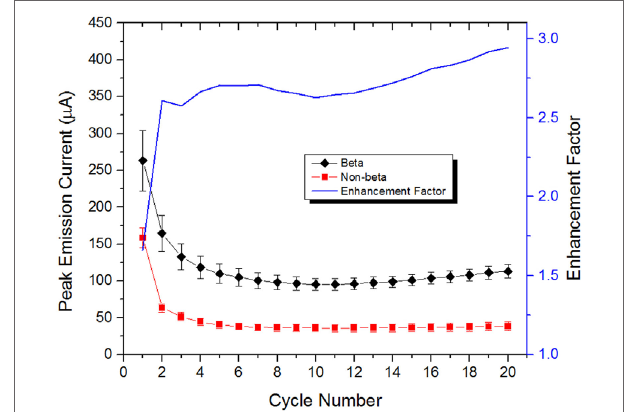
FigUre 5 | Average temporal peak emission current values for sample set A, showing the beta ( 63 Ni) current to be consistently higher than the non-beta ( 59 Ni) current. The enhancement factor (defined in the main text) is also shown on the right-hand axis. The error bars represent the standard error on the mean of all runs in sample set